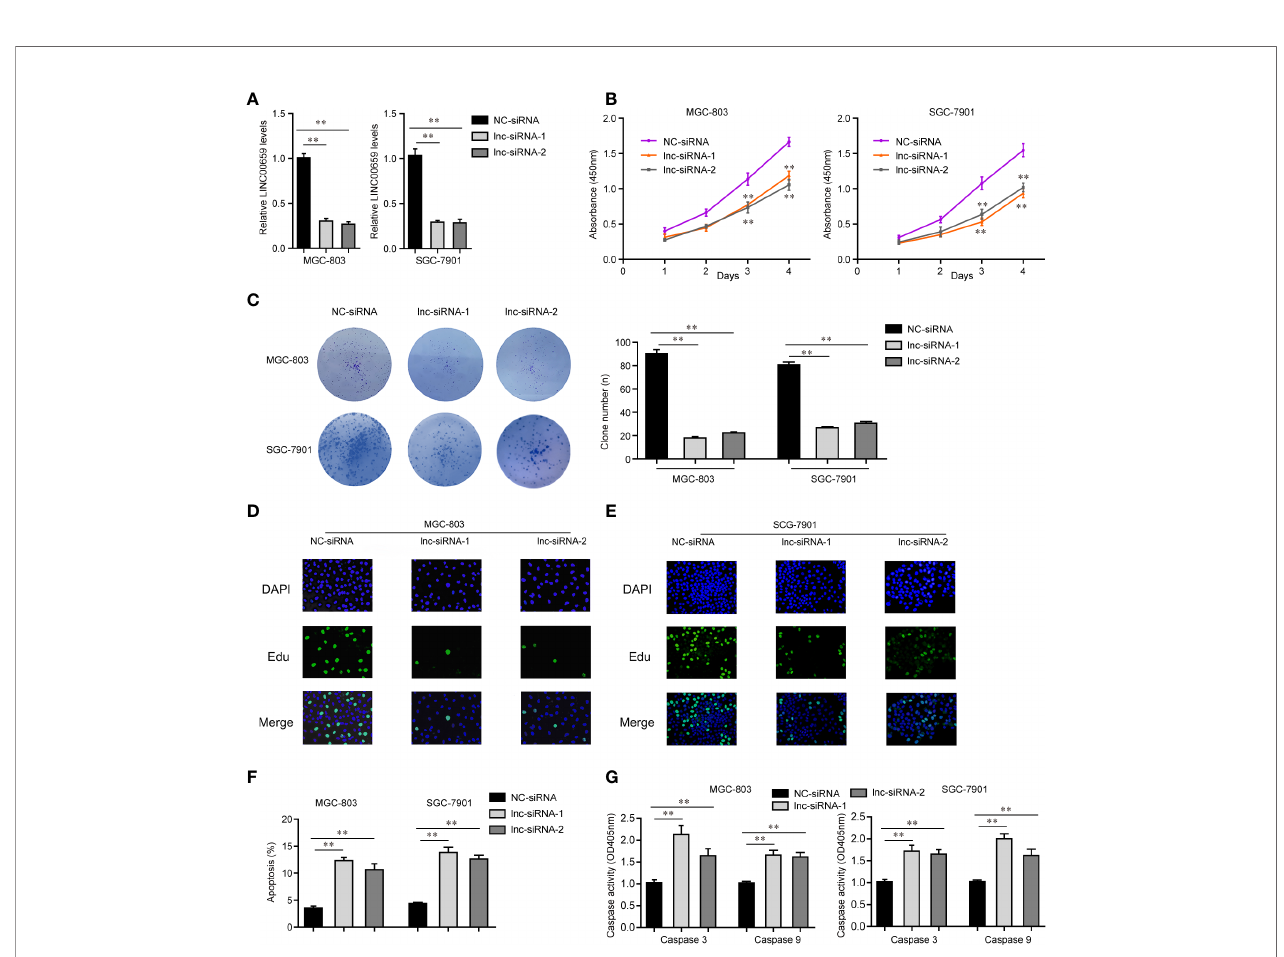
FIGURE 3 | In fl uence of LINC00659 on GC cell growth and apoptosis. (A) qPCR analyses detected LINC00659 levels. (B) CCK-8 assays. (C) Clonogenic assays. (D, E) EdU assays detected GC cell proliferation. Red represented the proliferation cells. Blue represented the nuclei. (F) Flow cytometry analyses examined the apoptosis. (G) Caspase 3/9 activity detection. **P <